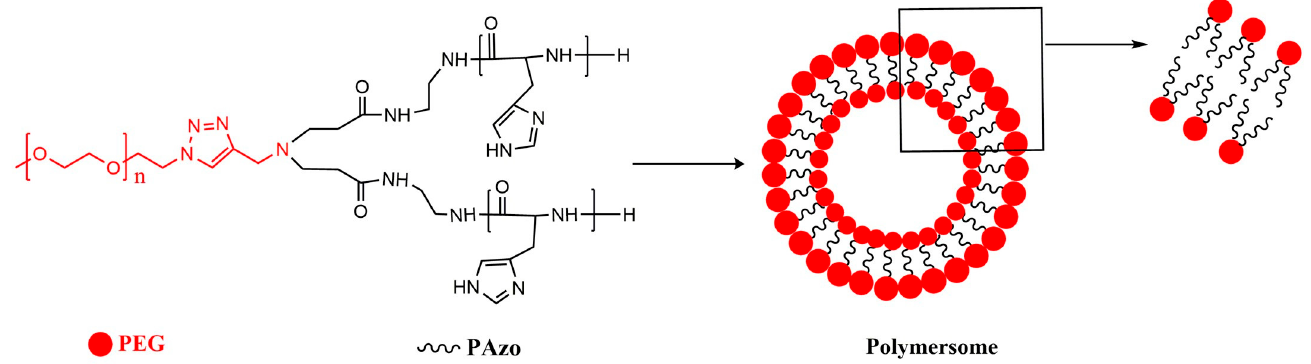
Figure 13. Representative Illustration of an Example of AB 3 Polymersome based on PEG-PAzo. The polymer mPEG2kDa-b-(polyHis29kDa)2 is highly buffered in the endolysosomal pH range prior to acidification and exhibits low cytotoxicity after 5 days of exposure (Figure 14). Below pH 7.4, the polymer evolved from cylindrical micelles to spherical micelles and ultimately to unimers as the pH decreased. The pH-induced structural transition of mPEG2kDa-b-(polyHis29kDa)2 nanostructures may be due to an increase in the weight fraction of the hydrophilic portion of mPEG2kDa-b-(polyHis29kDa)2 and may contribute to the disruption of the endosomal membrane. Furthermore, the hydrophilic model dye 5(6)-carboxyfluorescein encapsulated in an aqueous polymer matrix exhibited slow and sustained release at pH 7.4 but highly accelerated release below pH 7.4, indicating the desired pH sensitivity of the system in the endosomal pH range [192].